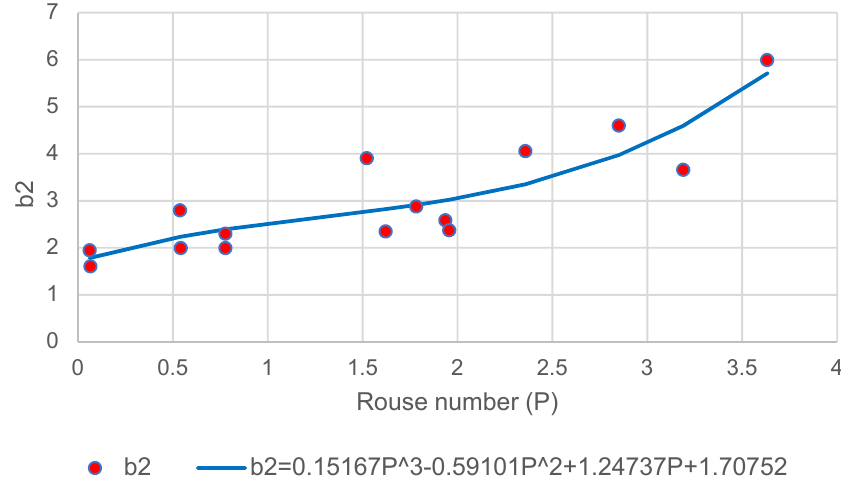
Figure 7. Rouse number regression vs. coefficient b 2 using KNN ( R 2 = 0.777).